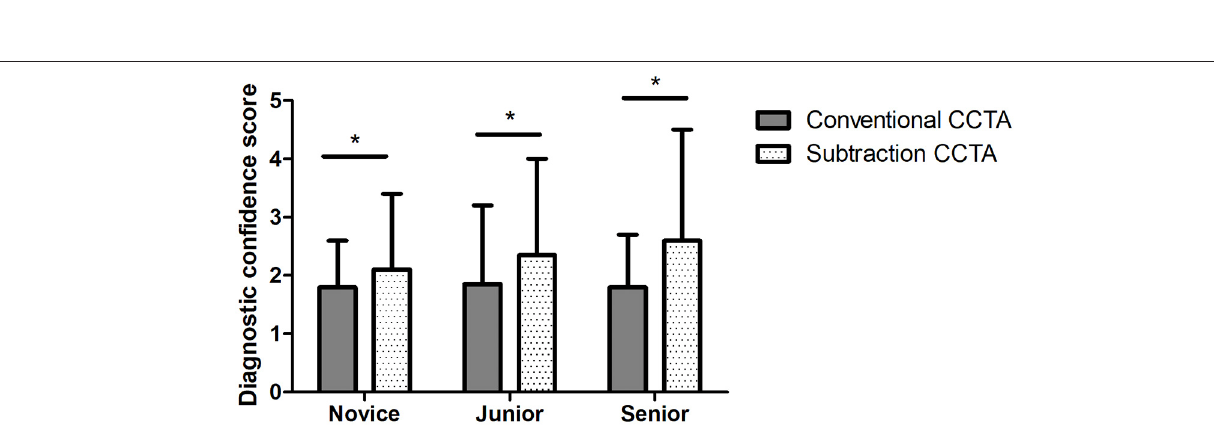
FIGURE 3 | Mean diagnostic confidence with conventional and subtraction coronary computed tomography angiography (CCTA) for novice, junior, and senior radiologists. The chart shows that the mean diagnostic confidence of subtraction CCTA is significantly higher than that of conventional CCTA, with p < 0.001 for all three groups. The * symbol indicates the value p <